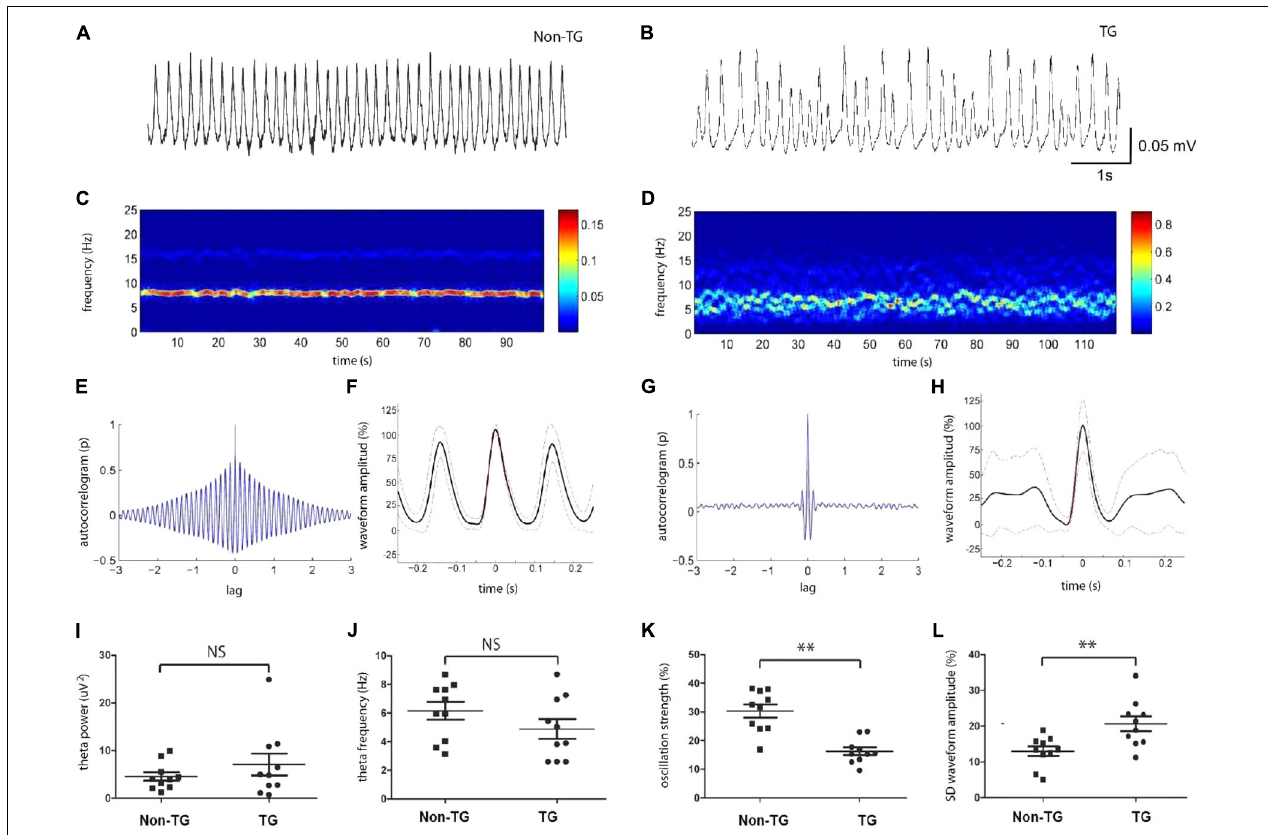
FIGURE 1 | Hippocampal theta activity was disrupted in young J20 mice. Representative trace of theta oscillation recorded at hippocampal ca1/subiculum area from J20 transgenic (TG) mice at age of P30 (B) , in comparison to the trace recorded from Non-transgenic (Non-TG) animal (A) . Spectrogram (100 s) from the same recordings shown above (C,D) . Autocorrelation of theta oscillations from TG and Non-TG mice (E,G) . Averaged oscillation waveform from 100 s recordings with standard deviation ( F,H , red dashed line). Statistics showed the oscillation power (I) and frequency (J) had no significant difference between TG and Non-TG group. (K) The oscillation strength from J20 group are significantly lower than those from the control group. (L) The standard deviation of the averaged waveform peak is significantly higher in J20 group compares to Non-TG group ( n = 10 in each group, ∗∗ p < 0.01 and NS p <